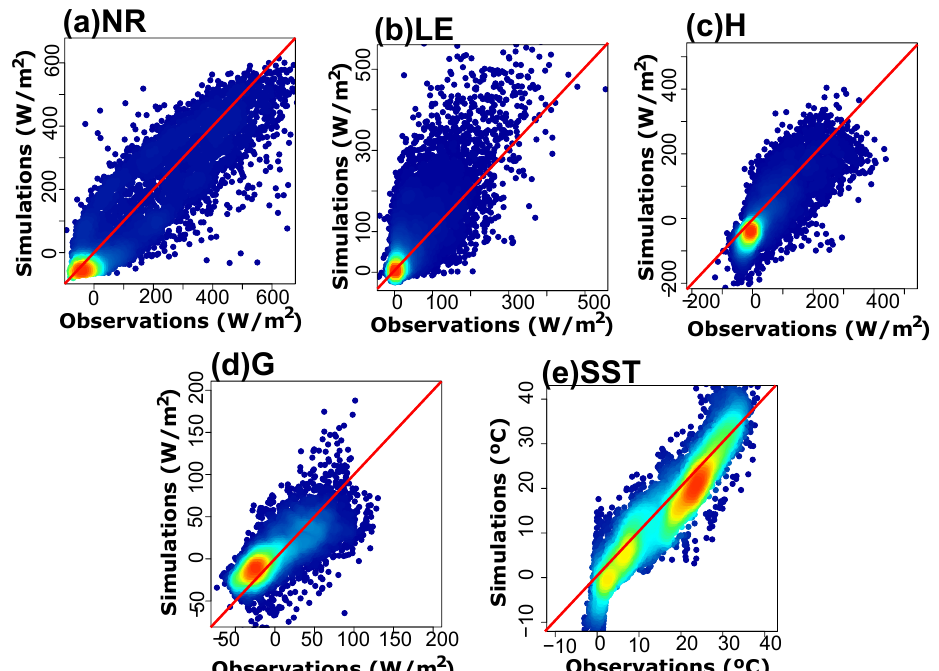
Figure 5. Density scatter plots of the calibration results at ARM-CF. From top-left to bottom-right: net radiation (NR, W/m 2 ), latent heat flux (LE, W/m 2 ), sensible heat flux (H, W/m 2 ), ground heat flux (G, W/m 2 ), and soil surface temperature (SST, ◦ C). In all panels, the x-axis represents the observed and the y-axis the simulated values.